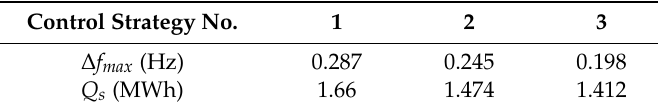
Table 3. Simulation results of Case